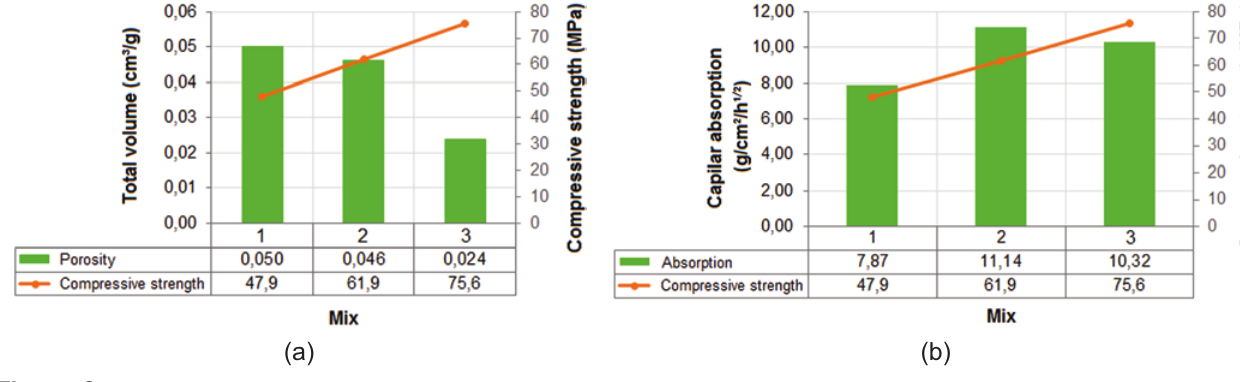
Relation of compressive strength with (a) total porosity and (b) capillary absorption